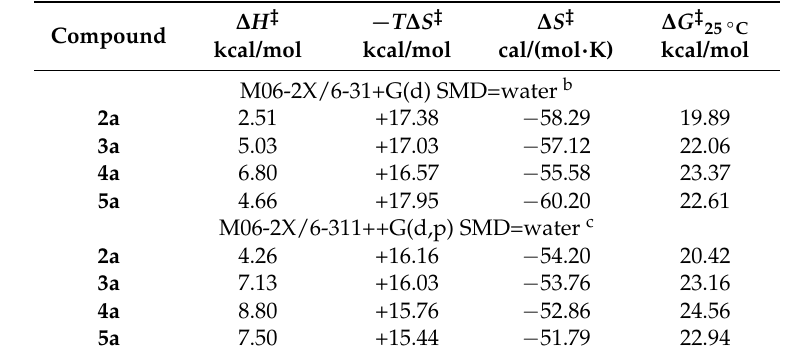
Table 4. Calculated free energy barrier for the formation of the transition state at 25 ◦ C (298.15 K) at the M06-2X/6-31+G(d) and M06-2X/6-311++G(d, p) levels, considering five water molecules. Solvent effect is SMD (solvent = water) a .